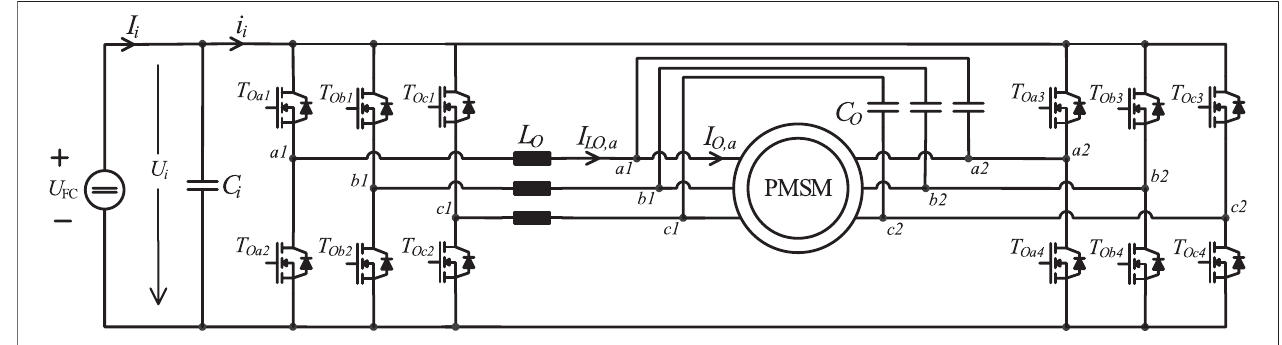
FIGURE 4 | DB-VSI inverter solution driving an open-end winding motor. An unfolder modulation is employed; i.e., only one VSI is operated with the switching frequency f s , while the second VSI is operated with the fundamental motor frequency f o . An output fi lter is placed between the high-frequency-operated VSI and the motor, in order to protect the latter from high d u /d t